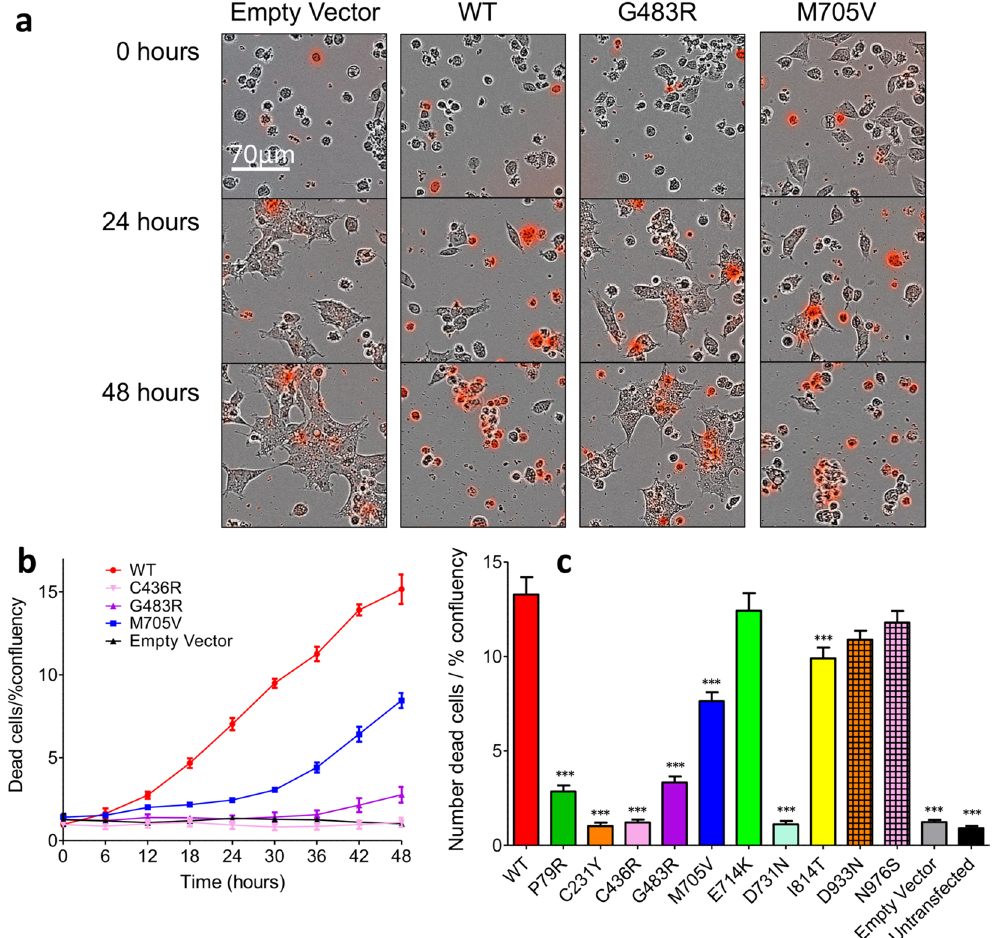
Figure 2. Selected GRIN2A mutations protect against glutamate-induced toxicity in HEK cells. ( a ) Superimposed bright field and pseudocolour red images, indicating fluorescent Cytotox Red dye in dead cells, of HEK cells transiently transfected with various GRIN2A mutant constructs, or empty vector. Free glutamate and glycine in the culture media causes cell death in those expressing functional NMDARs over 48 hours. Images captures at 20x using the IncuCyte live-cell imaging system. ( b ) Representative time course of cell death, normalised to initial confluency in each well, n = 5 wells, Mean ± SEM. ( c ) Plot of cell mortality for GRIN2A mutants normalised to initial confluency per well. Mutants P79R, C231Y, C436R, G483R, M705V, D731N and I814T are protective against glutamate toxicity either due to reduced trafficking and/or reduced functionality of the receptors. *** p < 0.001 Dunnett’s corrected one-way ANOVA. Averaged data from n = 15 wells per construct except for G483R, E714K, D933N and N976S where n = 12 wells, 3 × 10 4 cells/well. Mean ±